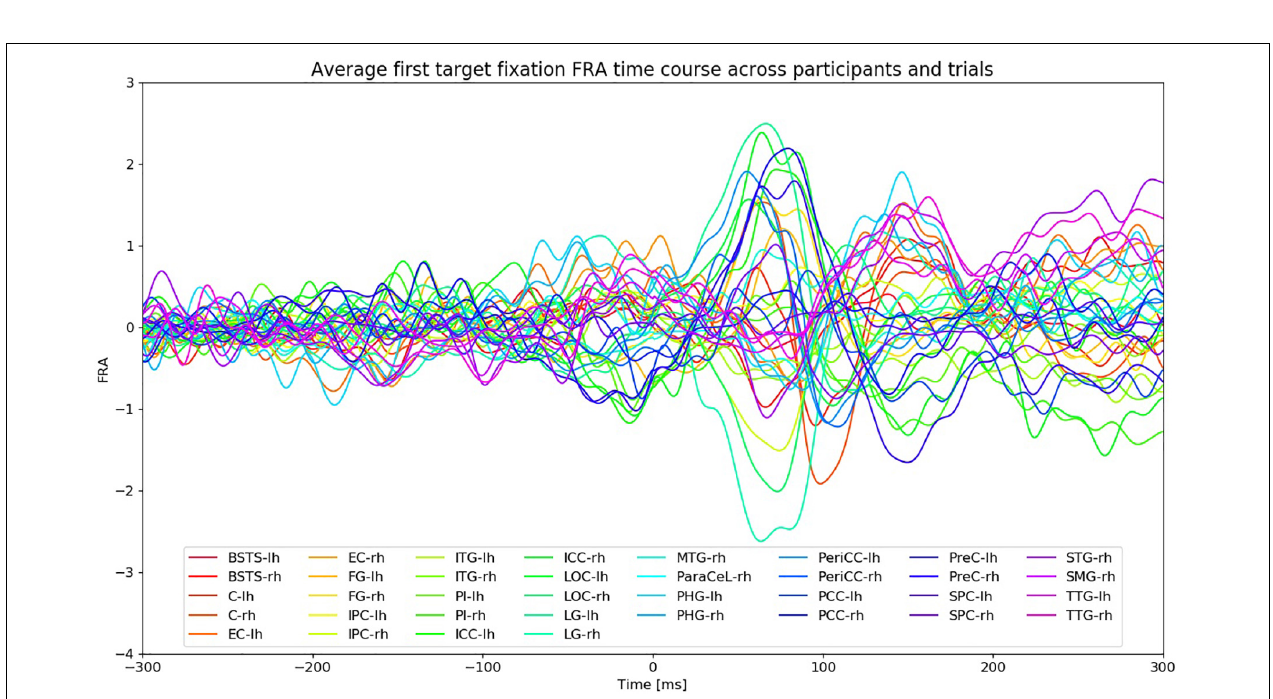
FIGURE 5 | FRA time courses of the first fixation on the search target averaged across all VS trials and participants. Fixation onset is at 0 ms. “lh” and “rh” stand for left and right hemisphere, respectively. Time courses from different ROIs are color-coded.